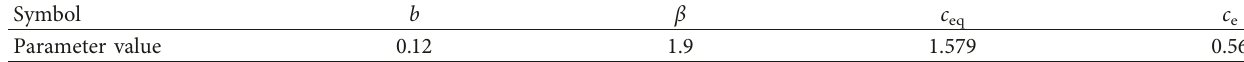
Table 4: Identification results.